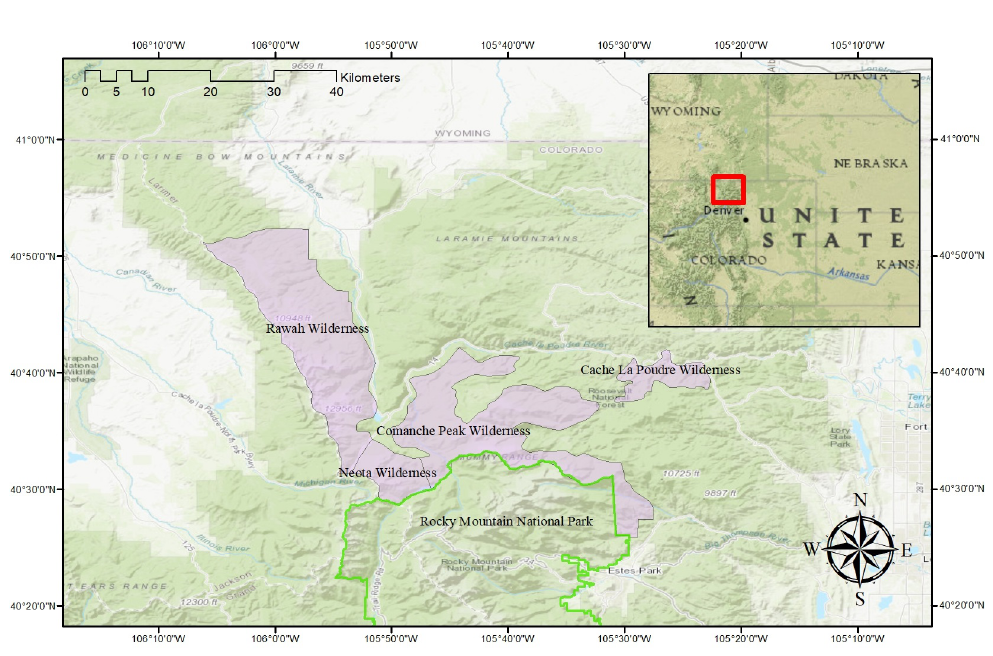
Figure 1. Study area location map: Roosevelt National Forest wilderness areas (extracted and modified from